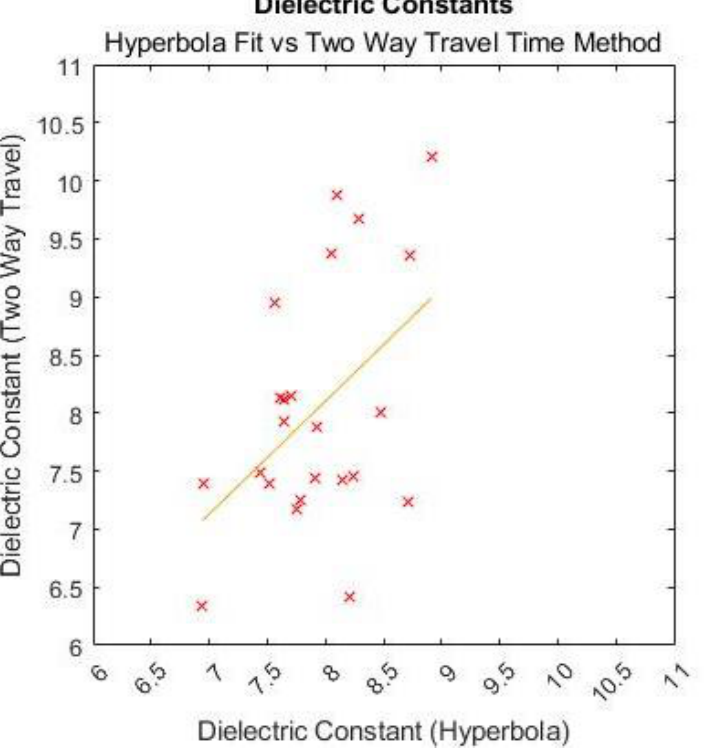
Figure 6. Correlation plot of dielectric constants found with hyperbola fitting and two-way travel time.